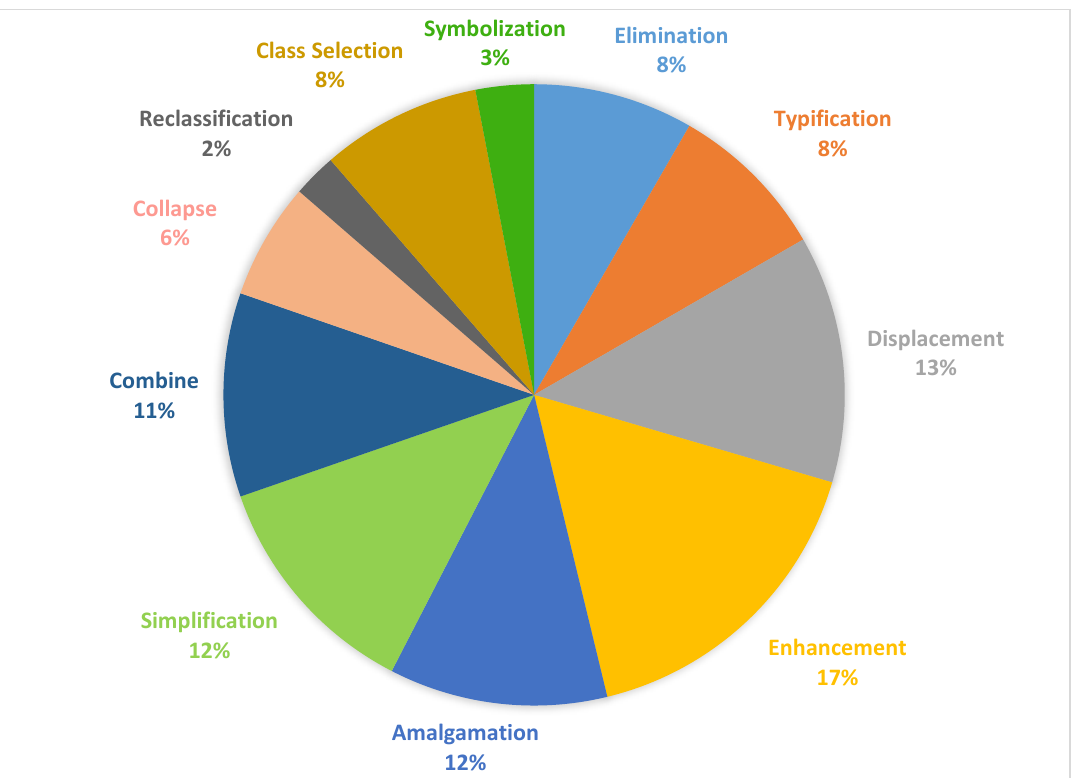
Figure 5. Number of appearances of generalization operators across primary studies (source: own study).